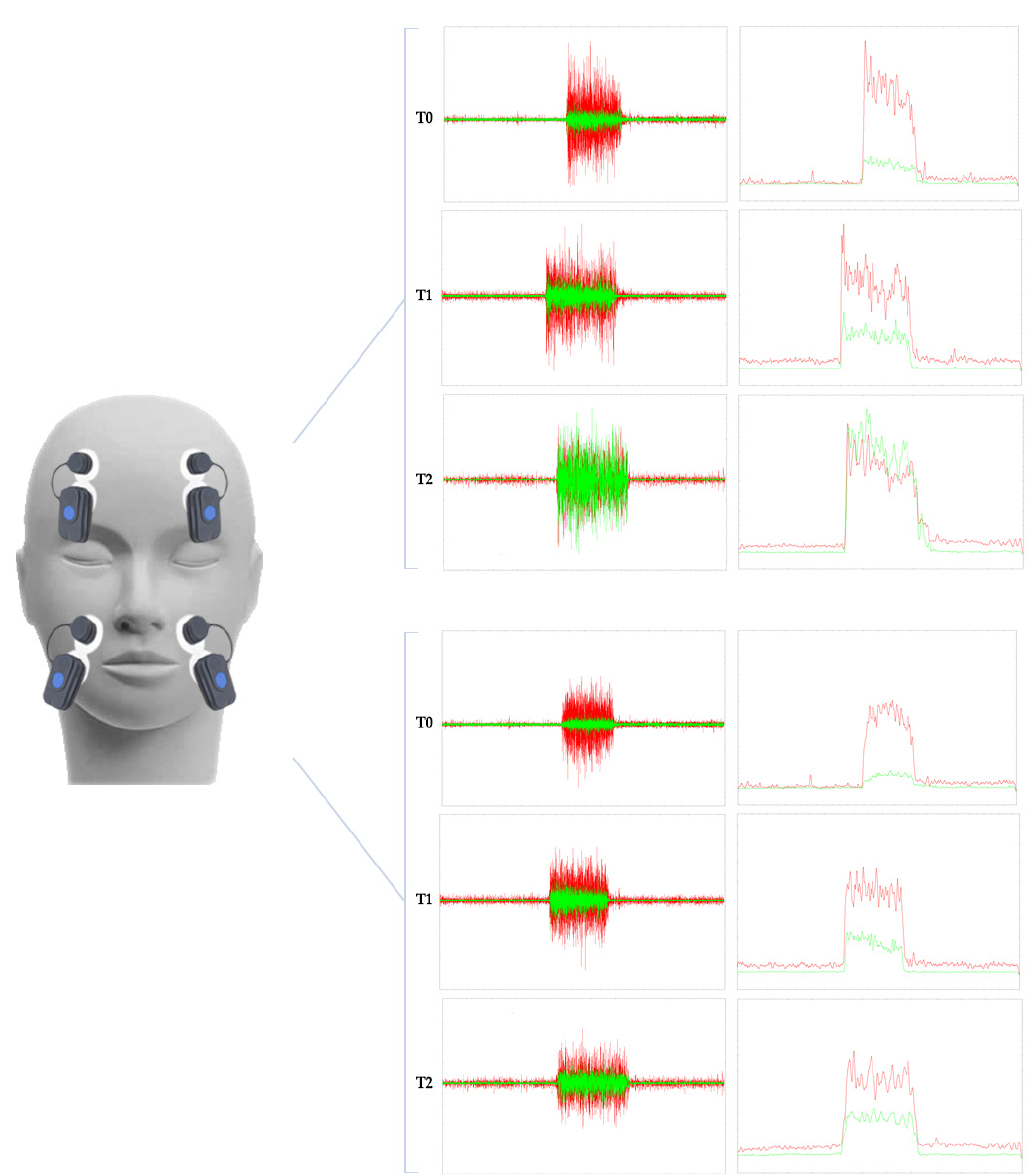
Figure 3. The graph shows the sEMG signal of the frontal muscle in the upper portion of the figure and the orbicularis oris in the lower portion of the figure. EMG representations are outlined in green for the side of the palsy and red for the side of the face not affected by the paralysis. At each timepoint of the evaluation of the case report, the raw data are represented on the left, while on the right the envelope of the sEMG signal is filtered and rectified to evaluate the ratio between the two mean amplitudes. So, for both muscles at T0, there is an obvious difference between paralysis and the normal side, while, at T1 and T2, the difference between the left and right-side decreases.